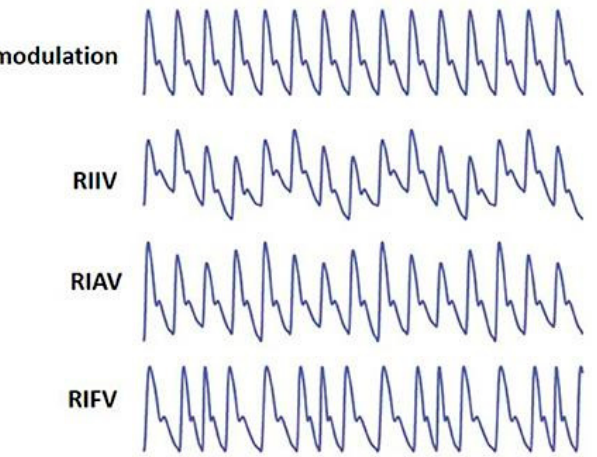
Figure 5. Respiratory-induced intensity variation (RIIV), respiratory-induced amplitude variation (RIAV), and respiratory-induced frequency variation (RIFV) respiratory-influenced variation to PPG signal [115] .